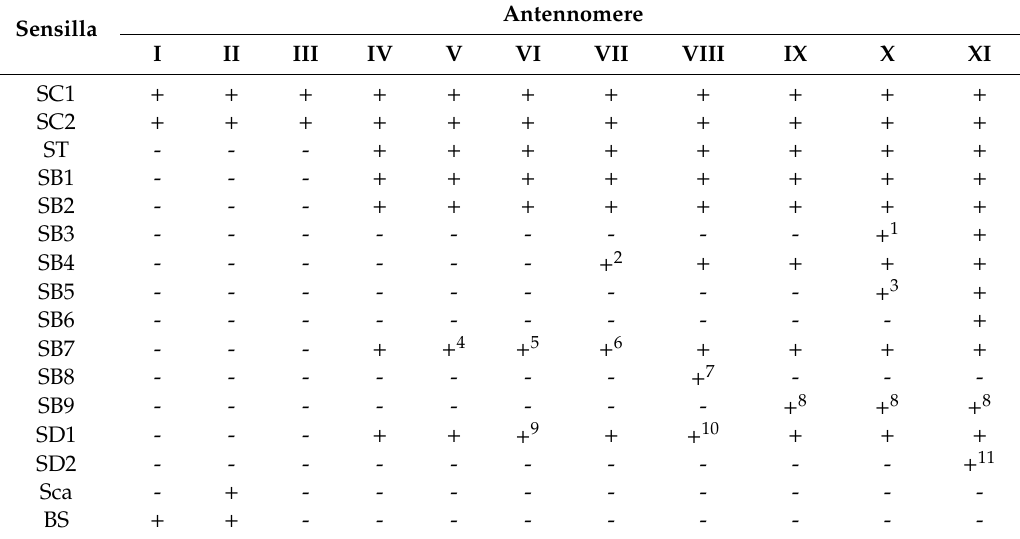
Table 3. Presence ( + ) or absence (-) of sensillum types and subtypes on di ff erent antennomeres of the examined Agriotes species. SC1 and SC2, sensilla chaetica subtypes 1 and 2, respectively; ST, sensilla trichodea; SB1–9, sensilla basiconica subtypes 1–9; SD1–2, dome-shaped sensilla subtypes 1–2; SCa, sensilla campaniformia; BS, Böhm